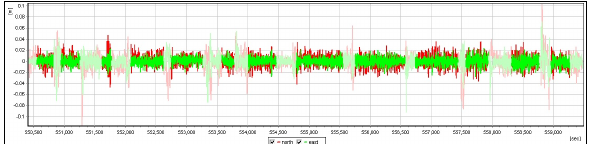
Figure 10 . Position difference between GNSS/INS methods of post-processing navigational data of the LiDAR mission In Figure 11 are the final processing results as a summary.